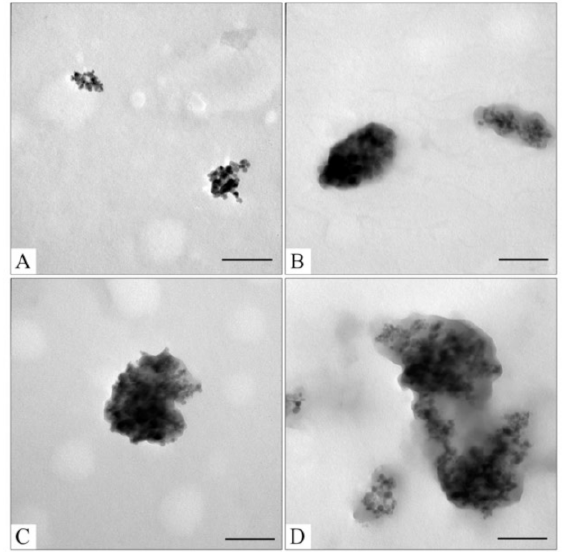
Figure 6. TEM images of Fe 3 O 4 @CaCO 3 /DOX73 ( A ); Fe 3 O 4 @CaCO 3 /DOX295 ( B ); Fe 3 O 4 @CaCO 3 /DOX525 ( C ); Fe 3 O 4 @CaCO 3 /DOX1045 ( D ). The bar indicates 100 nm.